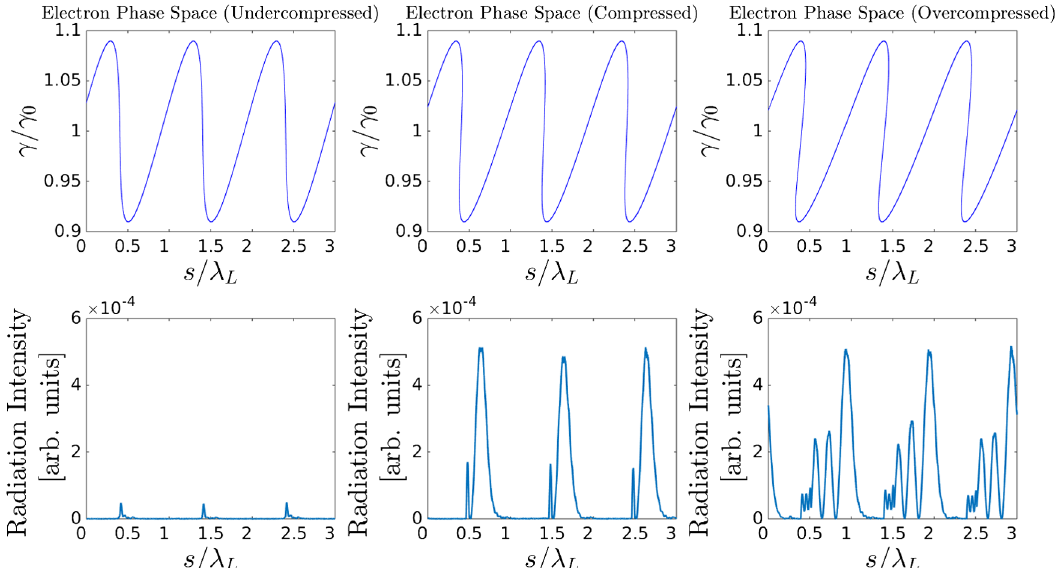
FIG. 6. The electron beam longitudinal phase space (top row) and field intensity profile (bottom row) as the beam traverses the undulator. The beam is first undercompressed and does not radiate significantly (left, two undulator periods), before it becomes optimally compressed and radiates strongly (middle, 12 undulator periods). If allowed to continue, the beam will radiate the lower intensity, subsequent Bessel peaks (right, 20 undulator periods).